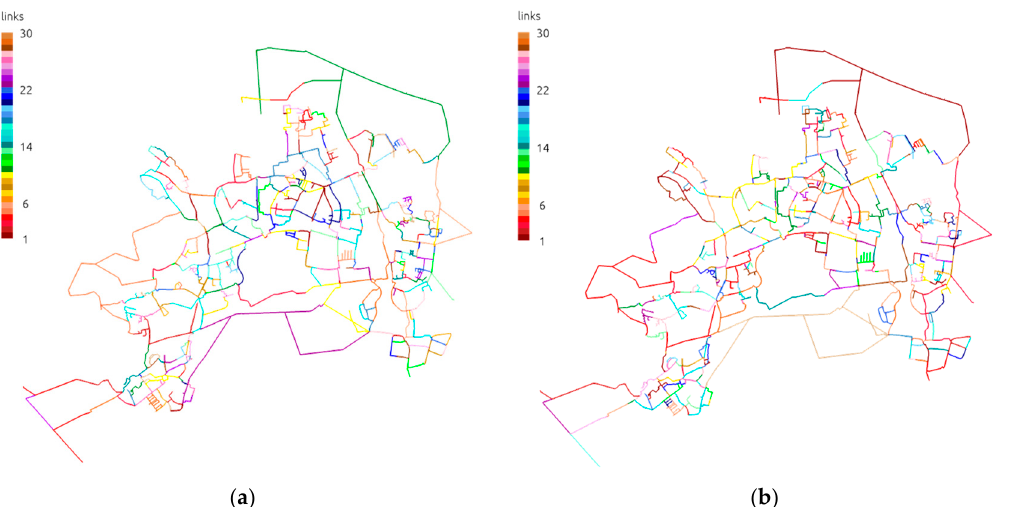
Figure 5. Transition phase wherein each pipe of the network should be replaced for ( a ) the solution identified with a blue circle on the Pareto front (Figure 4) and ( b ) the solution identified with a green circle on the Pareto front (Figure